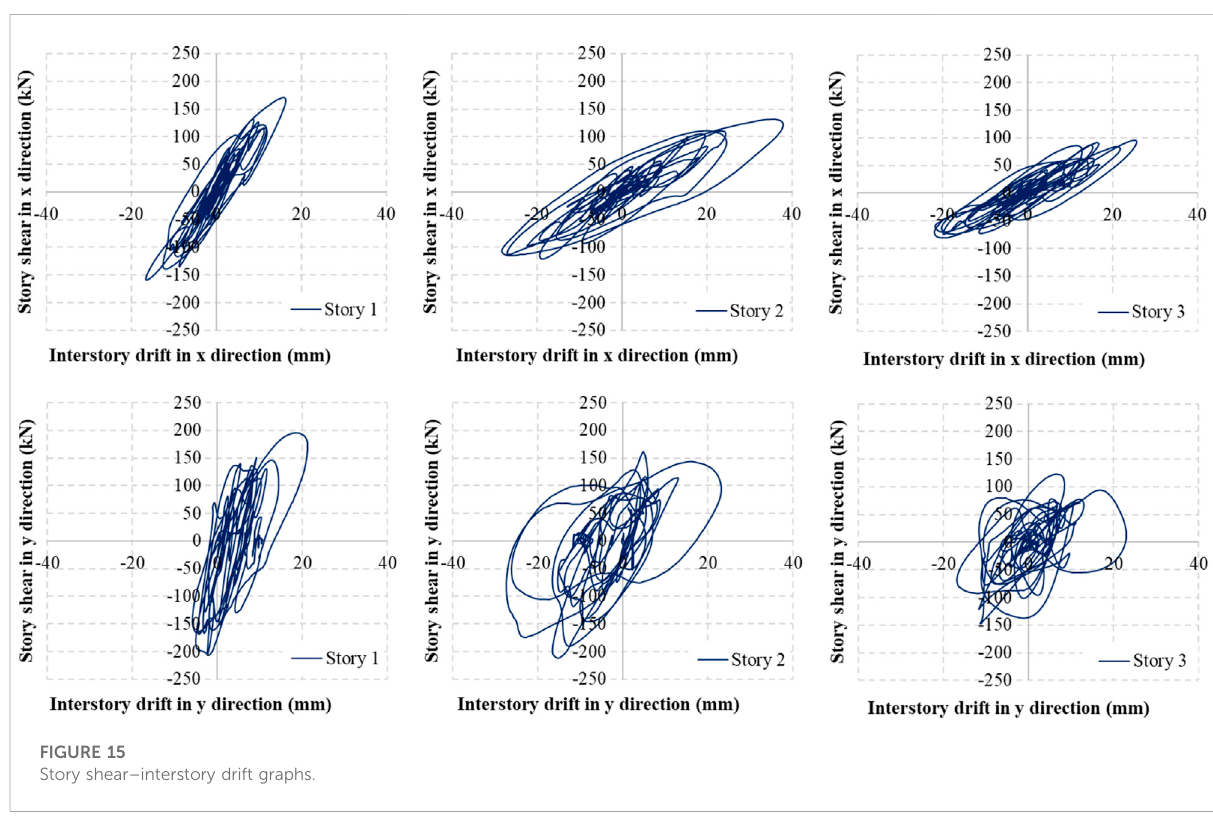
FIGURE 15 Story shear – interstory drift